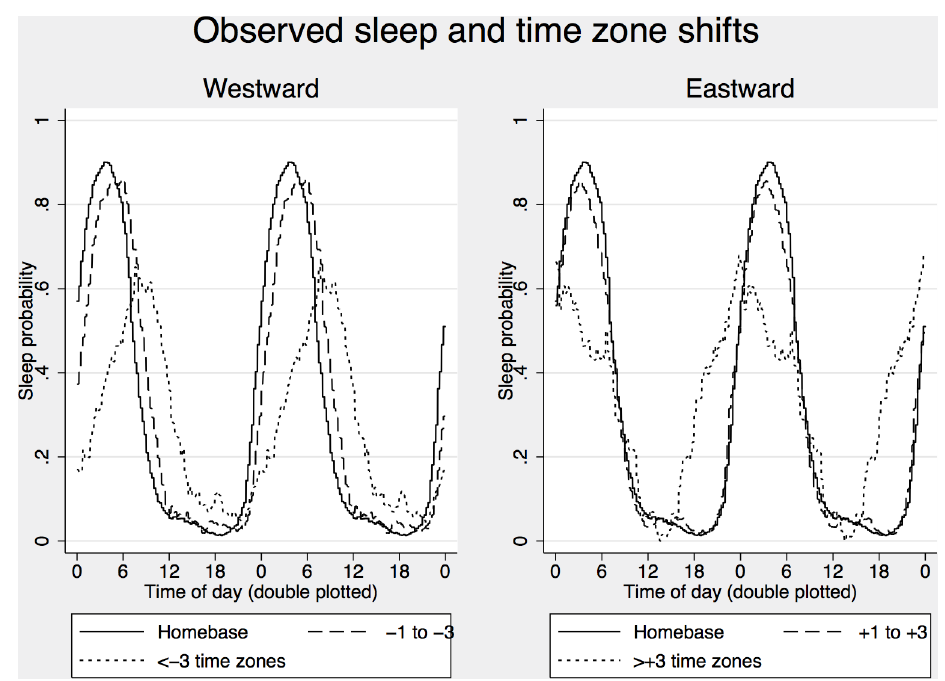
Figure 2. Observed sleep probability across time of day for the home base time zone and westward time zone shifts (left) and eastward time zone shifts (right).